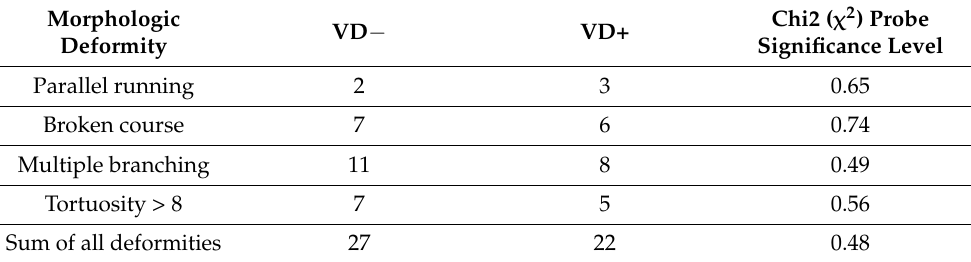
Table 1. Pooled number (normalized in 8/8 rats) of morphological deformities found in the resistance- artery network of the left-anterior-descendent coronary artery of vitamin-D-deficient (VD − ) and vitamin-D-supplemented (VD+) groups.